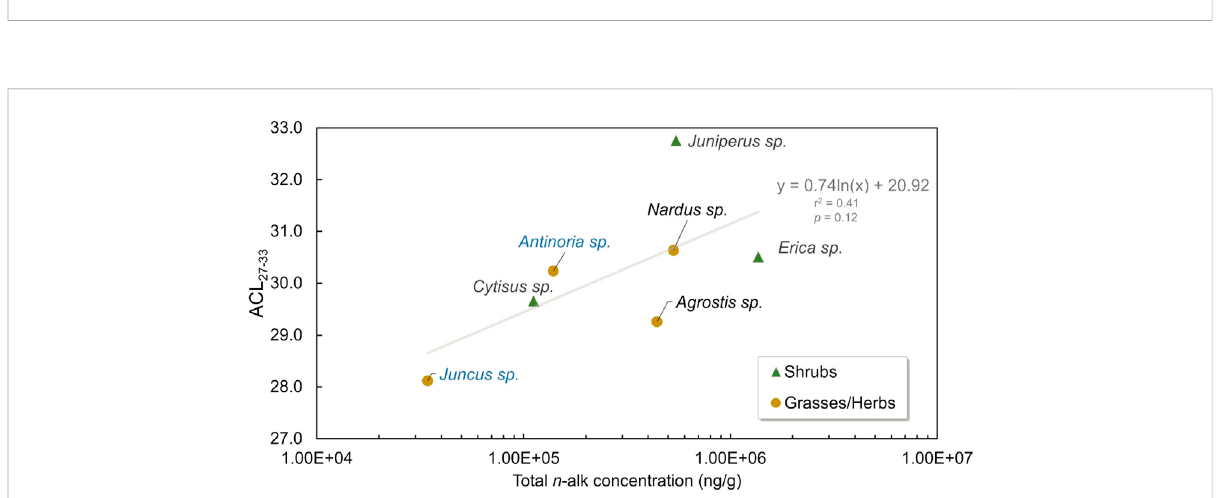
FIGURE 3 n -alkane distributions andcompound-speci fi cisotopicvalues(C 25 — C 35 )ofthedominant plants,vegetationlitter(L.),soilandsurfacesediment samples of the Lake Peixão area. The whiskers correspond to 1 SD, where multiple measurements on the respective compound were performed. *Normalization against the total n -alkane concentration of each sample.